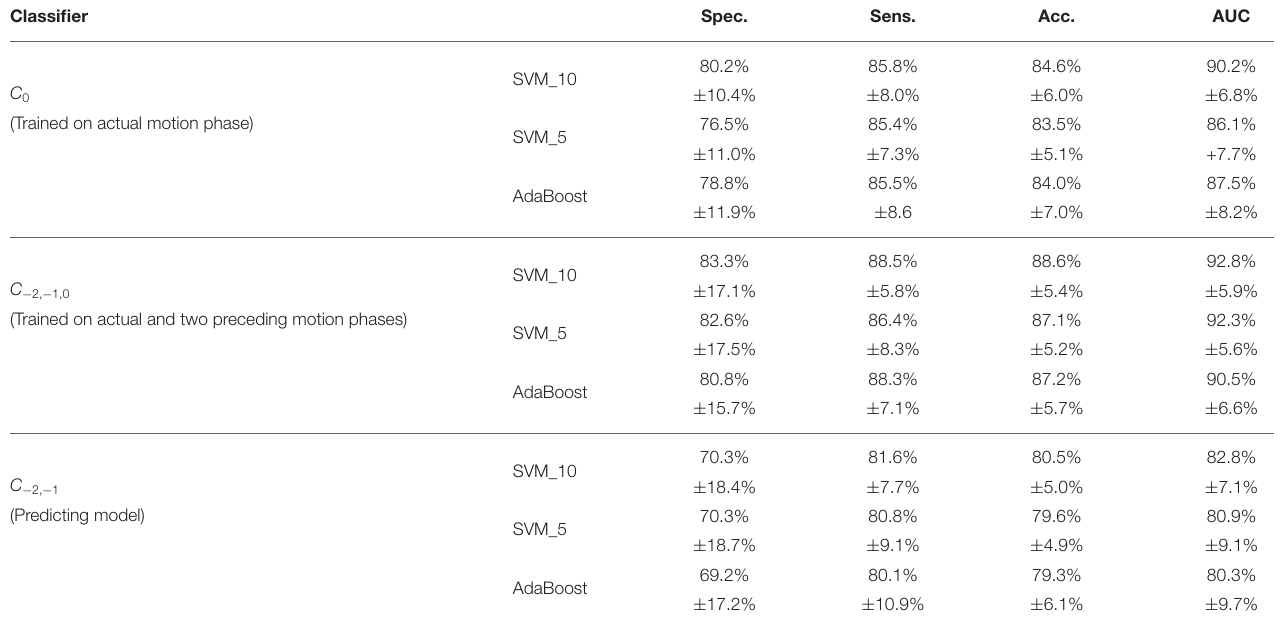
TABLE 5 | Overview of the leave-one-patient-out cross- validation results for all classifiers taking both feet into account.